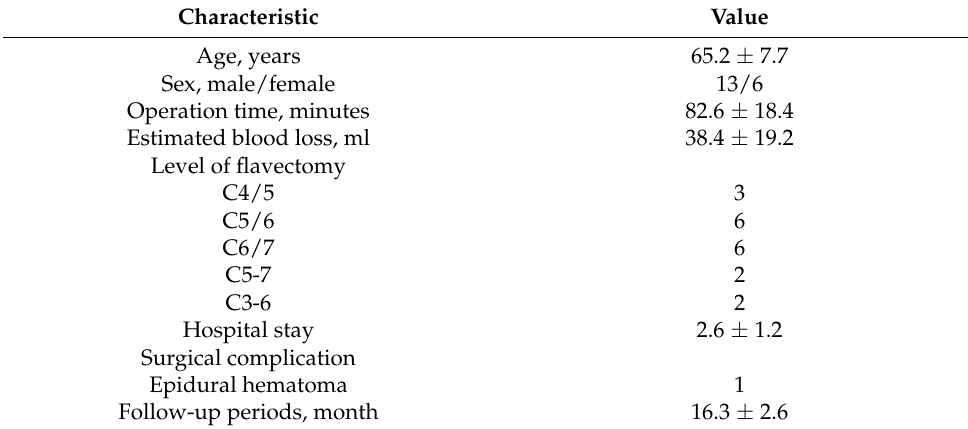
Table 1. Patient characteristics.